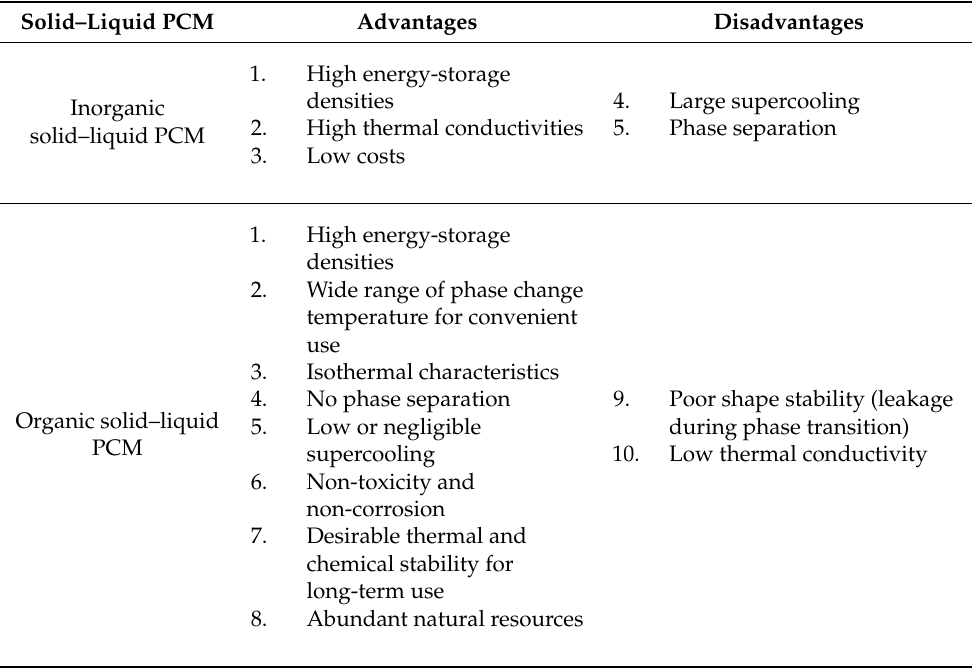
Table 2. Advantages and disadvantages of organic solid–liquid PCM and inorganic solid–liquid PCM [94,100,101]. Solid–Liquid PCM Advantages Disadvantages